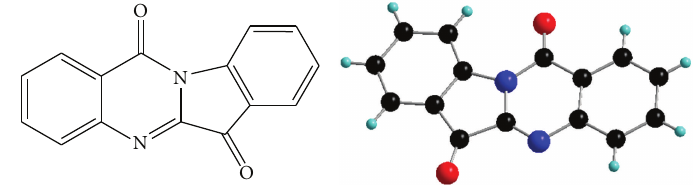
Figure 1: The chemical structure of tryptanthrin.